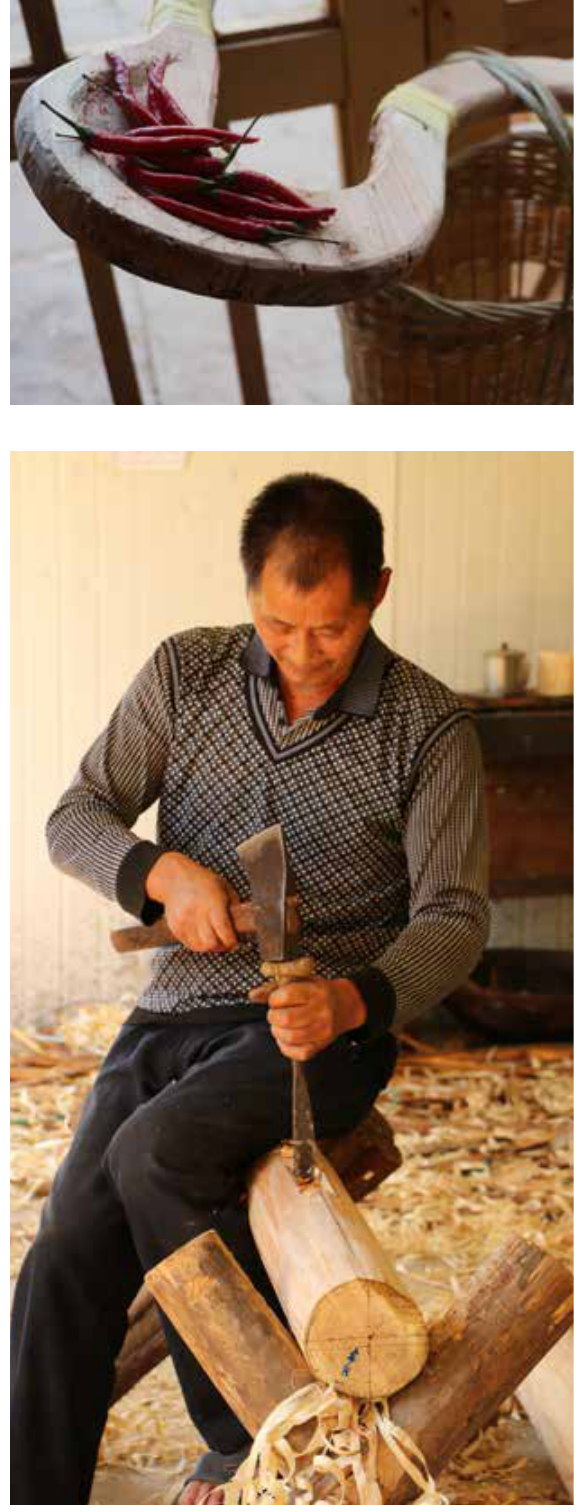
Figure 11 (top, page 128): Erecting the structure for the Miaoxia Community Kitchen in July 2015. Source: author . Figure 12 (bottom, page 128): Visitors to the 2015 Maker Faire at The Hong Kong Polytechnic University